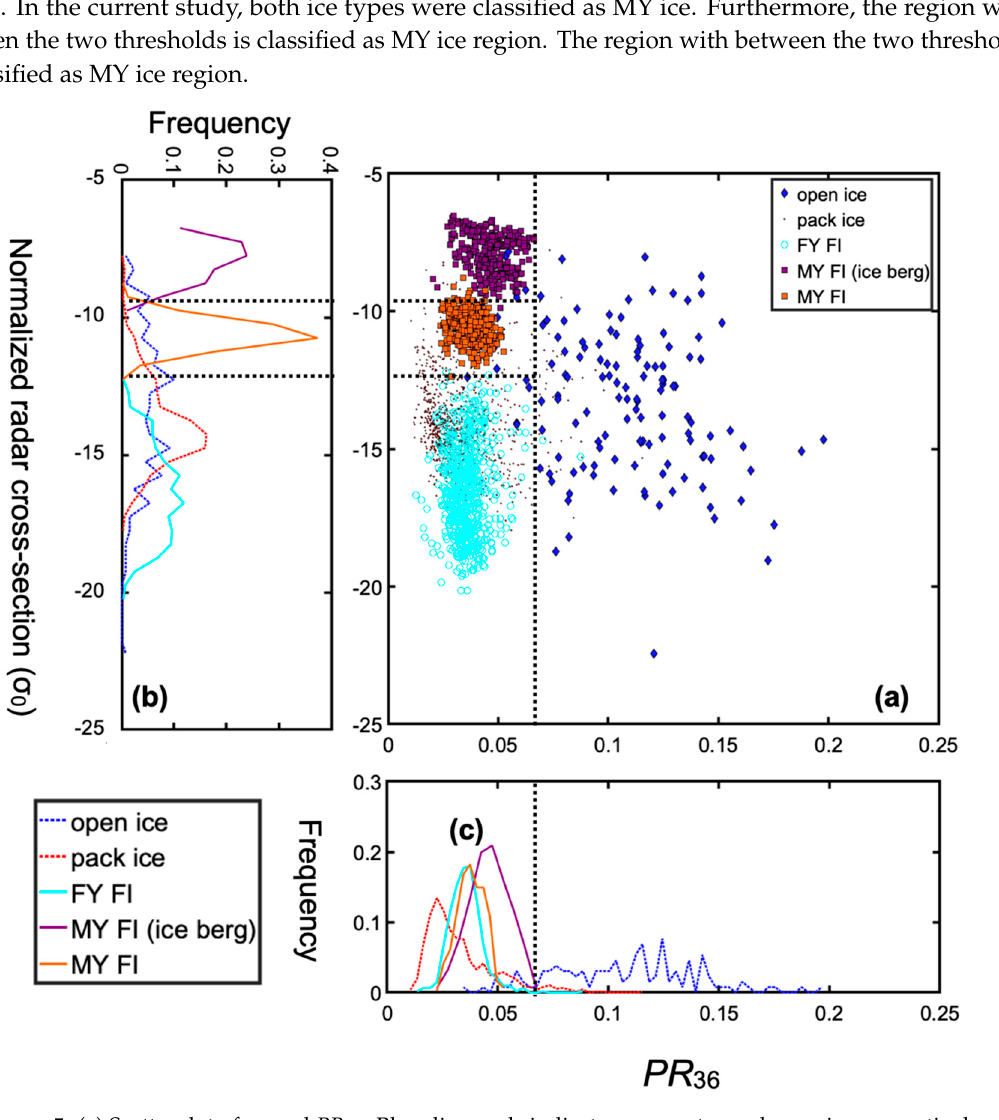
Figure 5. ( a ) Scatterplot of σ 0 and PR 36 . Blue diamonds indicate open water and open ice, respectively. Brown dots indicate pack ice. Light blue circles indicate FY fast ice, and purple or orange squares indicate MY fast ice, including icebergs and MY fast ice, respectively. ( b , c ) Histograms of σ 0 and PR 36 , respectively. The dotted line shows the threshold of the ice classification algorithm.